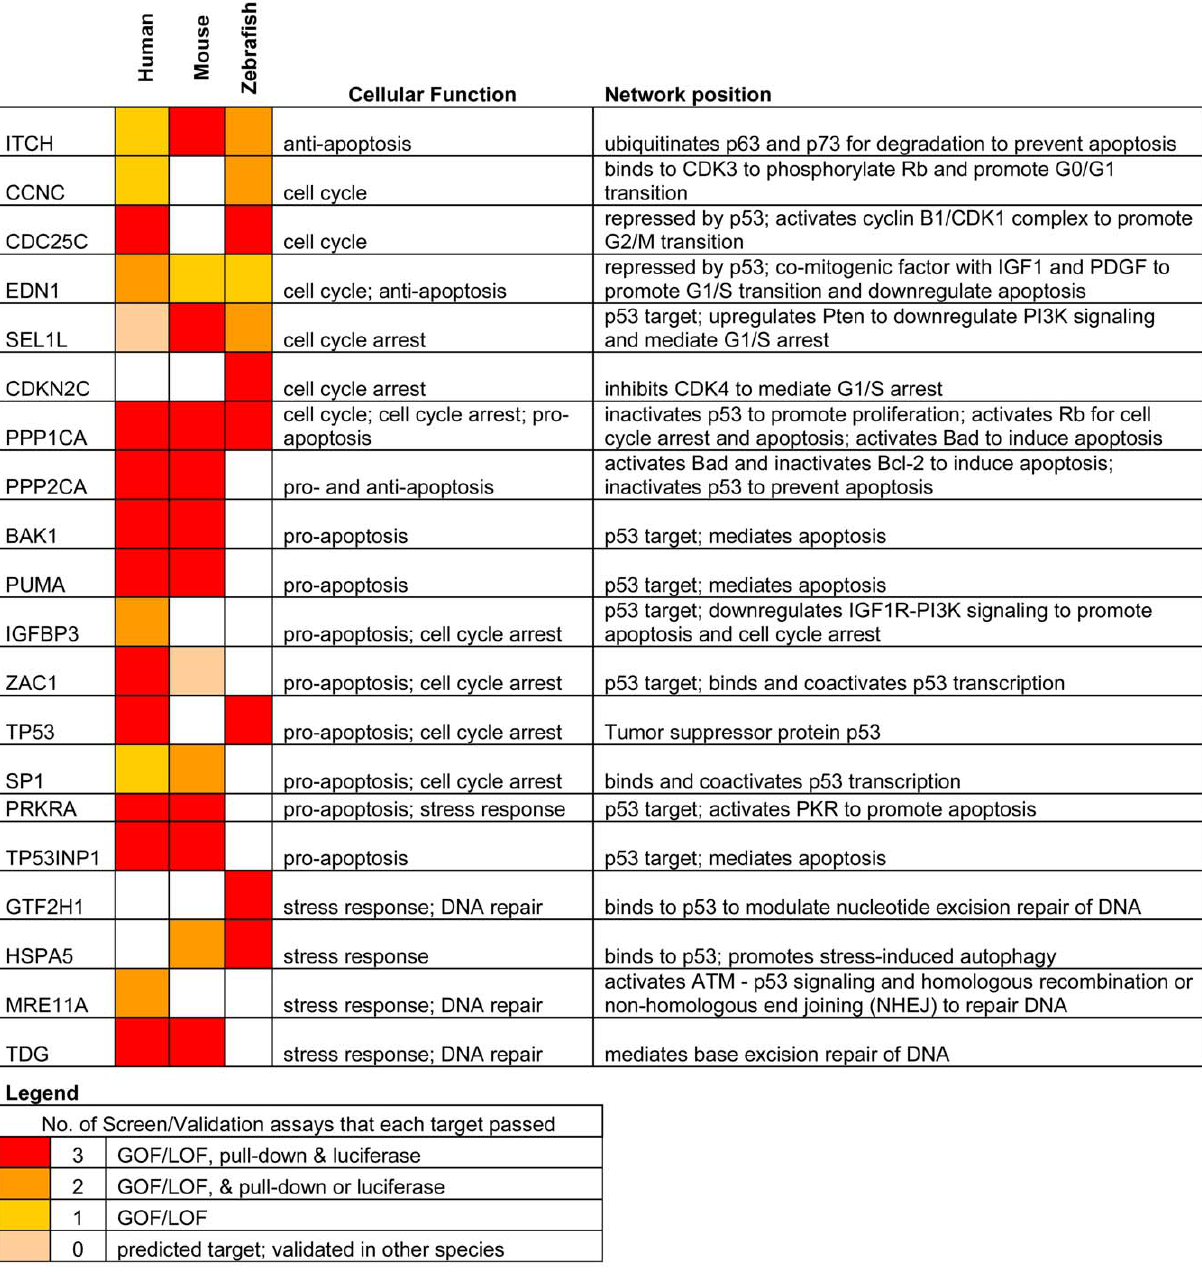
Figure 5. Summary of genes in p53 network that are directly targeted by miR-125b. Only targets that passed $ 2 validation assays, in at least one species, are shown. Red: predicted targets validated by 3 assays; Orange: predicted targets validated by 2 assays; Yellow: predicted targets validated by 1 assay; Pink: predicted targets not validated by any assay, but validated by 3 assays in another species.